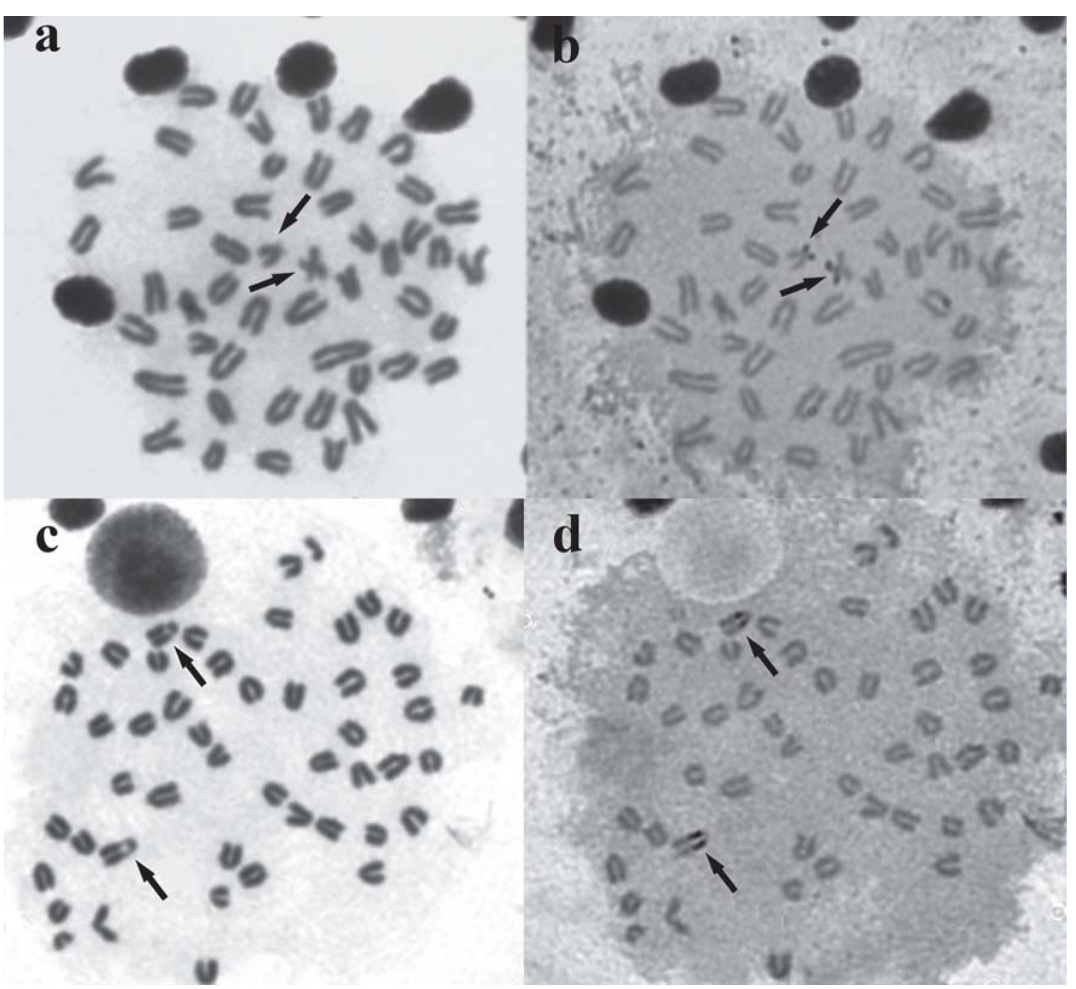
Fig. 3. Metaphases of Rhomboplites aurorubens (a-b) and Ocyurus chrysurus (c-d) sequentially stained with Giemsa (left) and AgNO (right). Arrows indicate the NOR-bearing 3